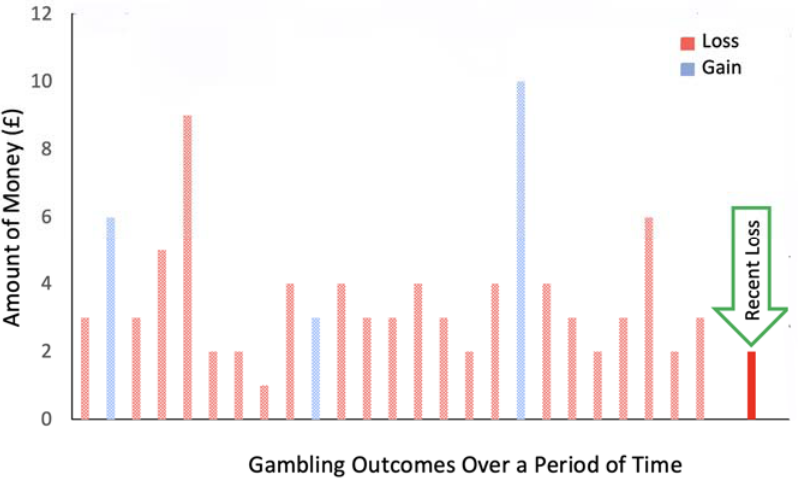
Figure 2. Most recent event (loss) from a dynamicaly experienced sequence of losses and gains.